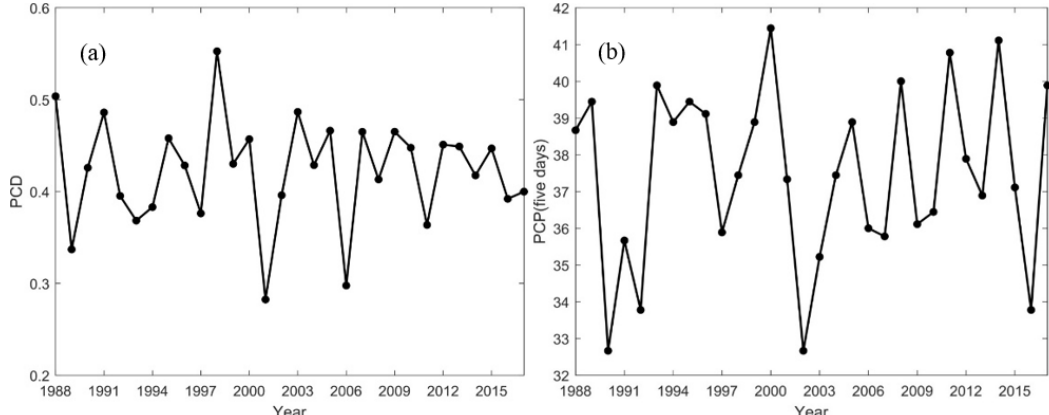
Figure 7. Interannual variation of ( a ) precipitation concentration degree (PCD) and ( b ) precipitation concentration period (PCP) in the TGRA from 1988 to 2017.